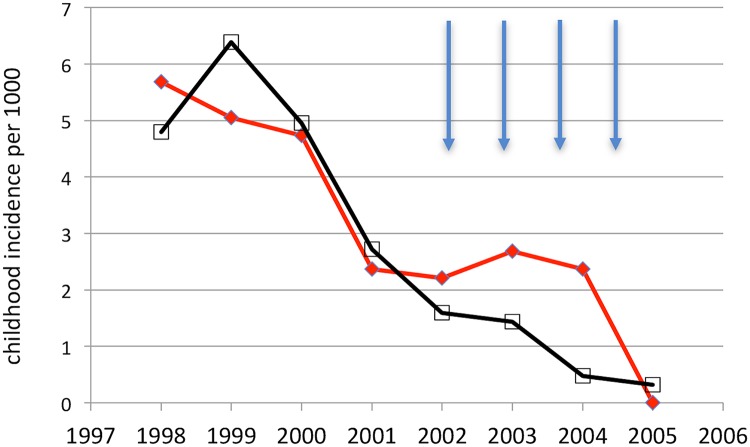
Confirmed VL case incidence during the 1998 to 2005 transmission seasons in collar villages (black line, N = 40) and control villages (red line, N = 40).Arrow represents when collars were fitted in late June/early July of each year before the start of transmission.